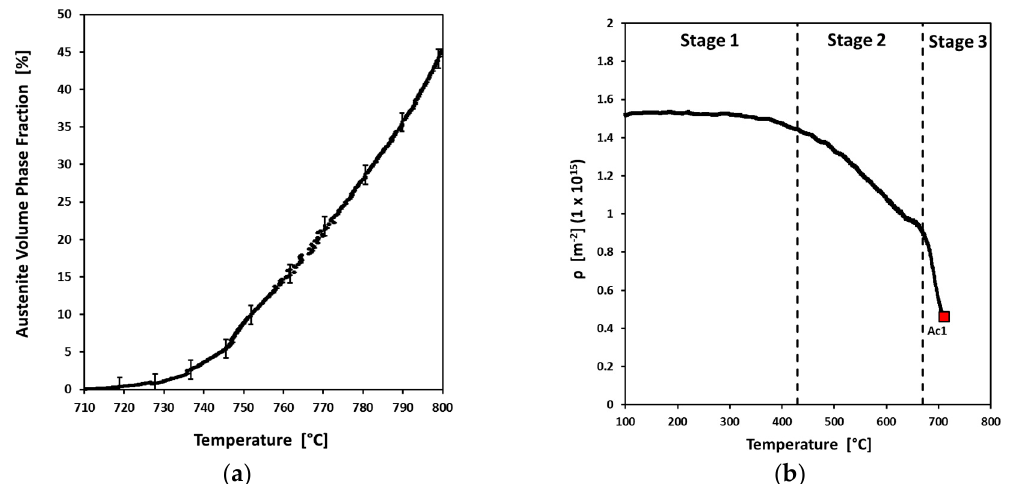
Figure 3. ( a ) Evolution of the austenite volume fraction versus temperature during continuous heating up to 800 °C (3 °C·s − 1 ) deduced from HEXRD experiments and Rietveld refinement procedure. ( b ) Evolution of the dislocation density in ferrite as a function of the temperature during the same experiment deduced from the Williamson-Hall procedure.